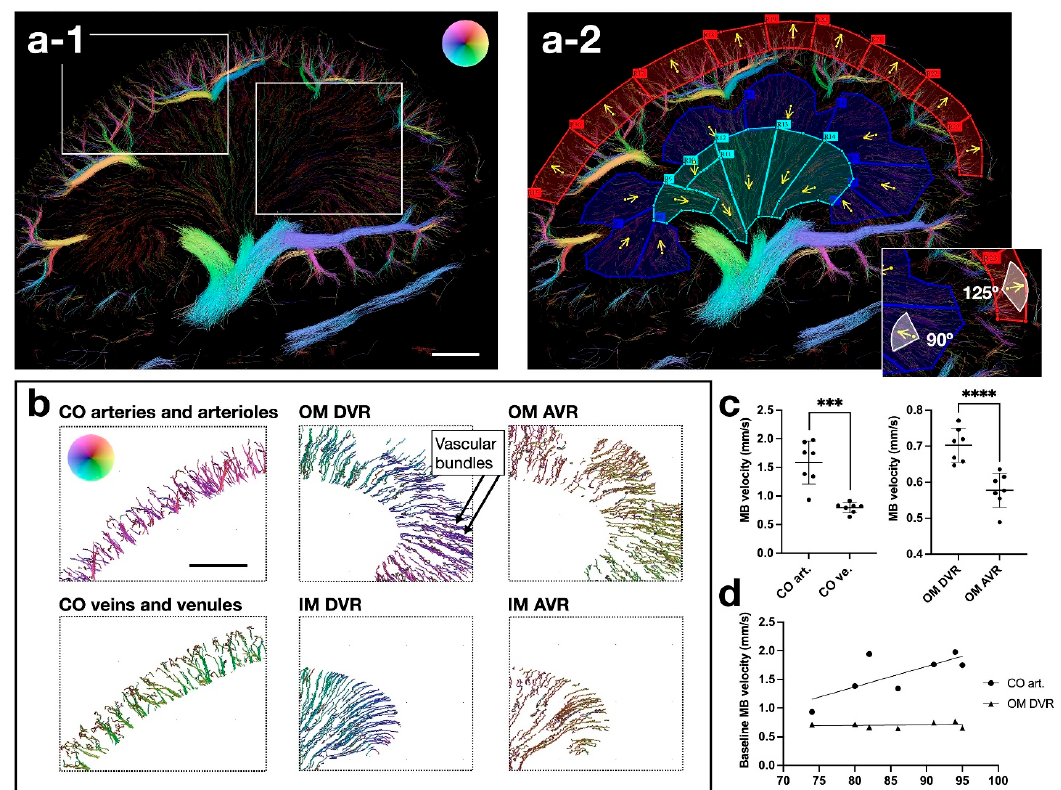
Figure 3. Segmentation of rat kidneys with separation of arteries/arterioles and veins/venules in the cortex, outer medulla, and inner medulla. ( a-1 , a-2 ) show an example of the regions used to separate arteries/arterioles and veins/venules in the three areas (color wheel velocity range: 0–20 mm/s). In ( a-2 ), red is the cortex, dark blue is the outer medulla, and turquoise is the inner medulla. The yellow arrows indicate the mean angle of the arterial flow direction. ( b ) shows the separated tracks from the inserts in ( a-1 ) (velocity range: 0–5 mm/s in the medulla, 0-20 mm/s in the cortex). ( c ) shows MB velocities (mean and standard deviation) from arterial vs. venous tracks (SRUS scan 1). ( d ) shows the relationship between baseline MB velocity in the arteries/arterioles of cortex and outer medulla and the MAP. AVR = ascending vasa recta, CO = cortex, DVR = descending vasa recta, IM = inner medulla, MB = microbubble, OM = outer medulla. *** = p ≤ 0.001, **** = p ≤ 0.0001. Scale bars = 2 mm.